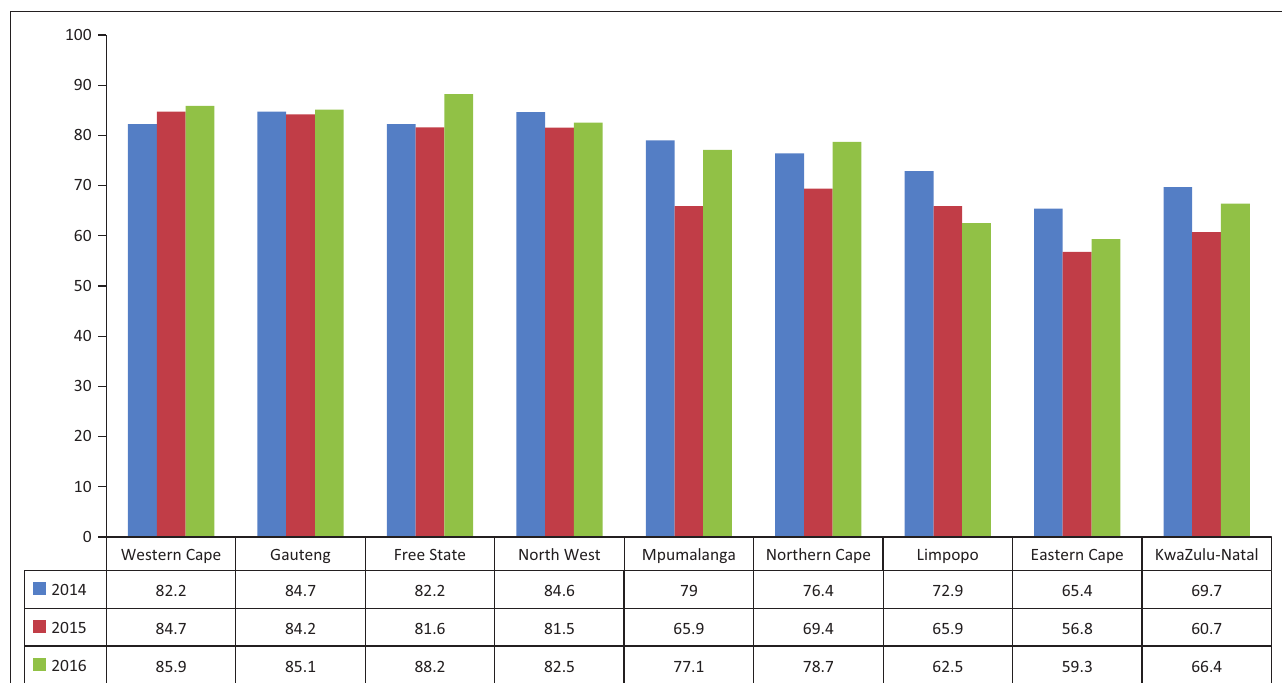
FIGURE 2: Three year performance of provinces.